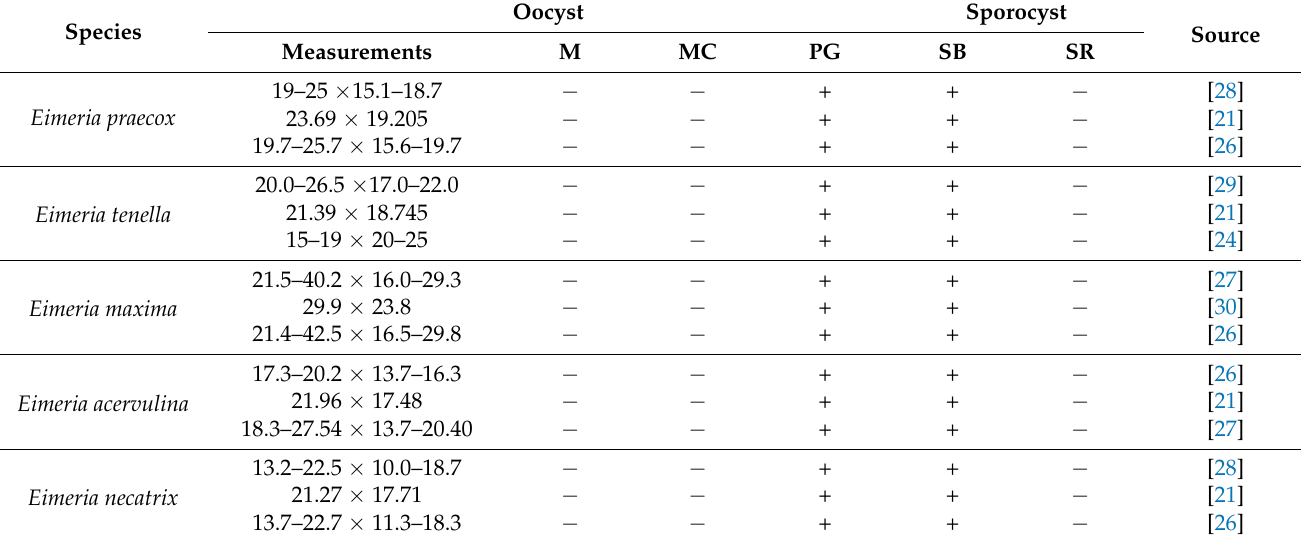
Table 3. Morphological comparison between coccidian oocysts detected in chickens in the present study and other related species from the same